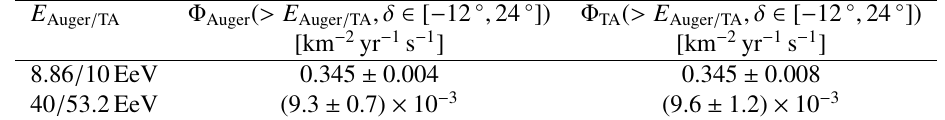
Figure 2. Integral flux reconstructed in the common declination band as a function of energy threshold. The red and blue bands display the statistical uncertainty on the flux above threshold energies measured by the Pierre Auger Observatory and Telescope Array, respectively. Table 1. Flux reconstructed in the declination band probed by both the Telescope Array and the Pierre Auger Observatory. E Auger /